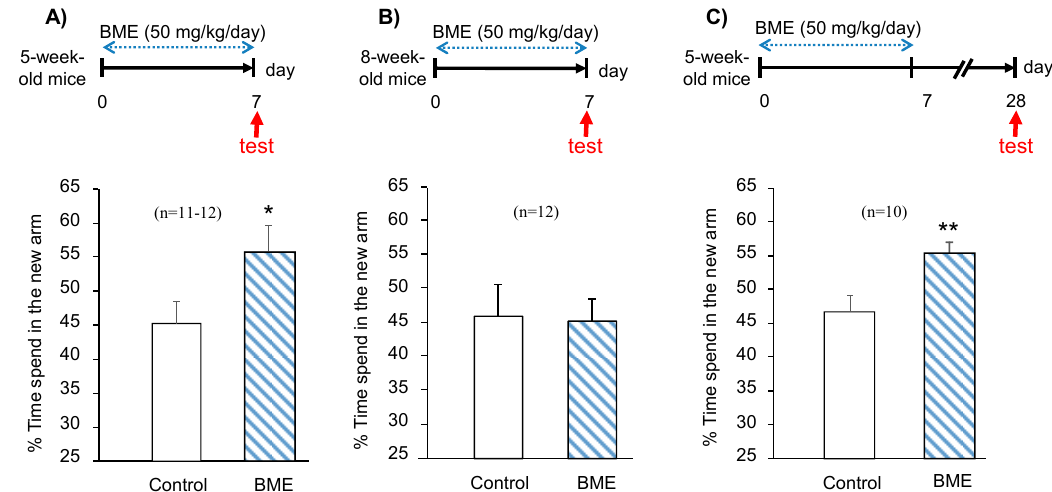
Figure 2. Effect of BME (50 mg/kg) on spatial working memory in 5-week-old and 8-week-old mice after 7 days of treatment. Spatial working memory was elucidated by the modified Y-maze test. Red arrows indicate the day behavioral tests were conducted. Summarized data obtained on 5-week-old mice (A) and 8-week-old mice (B) after 7 days BME treatment; 5-week-old mice received daily BME at a dose of 50 mg/g (p.o.) for 7 days, and then the spatial working memory was evaluated at 28 days after the last drug administration (C). Results are expressed as % of the time animals spent exploring the novel arm in the test trial. Each data column represents the mean ± SEM ( n = 10–12). ** p < 0.01; * p < 0.05 vs. the control group.